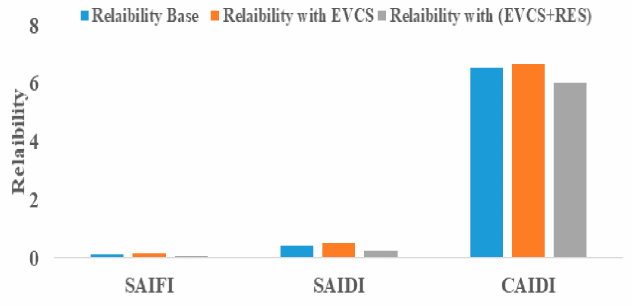
Figure 8. Reliability of modified IEEE 33-bus system.